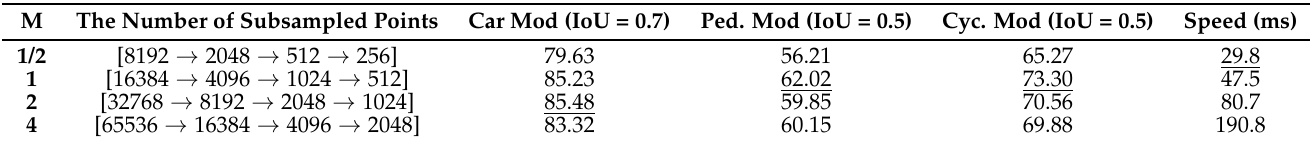
Table 5. Performance of different point numbers. M means the shrink time compared to the baseline. The best results are underlined.